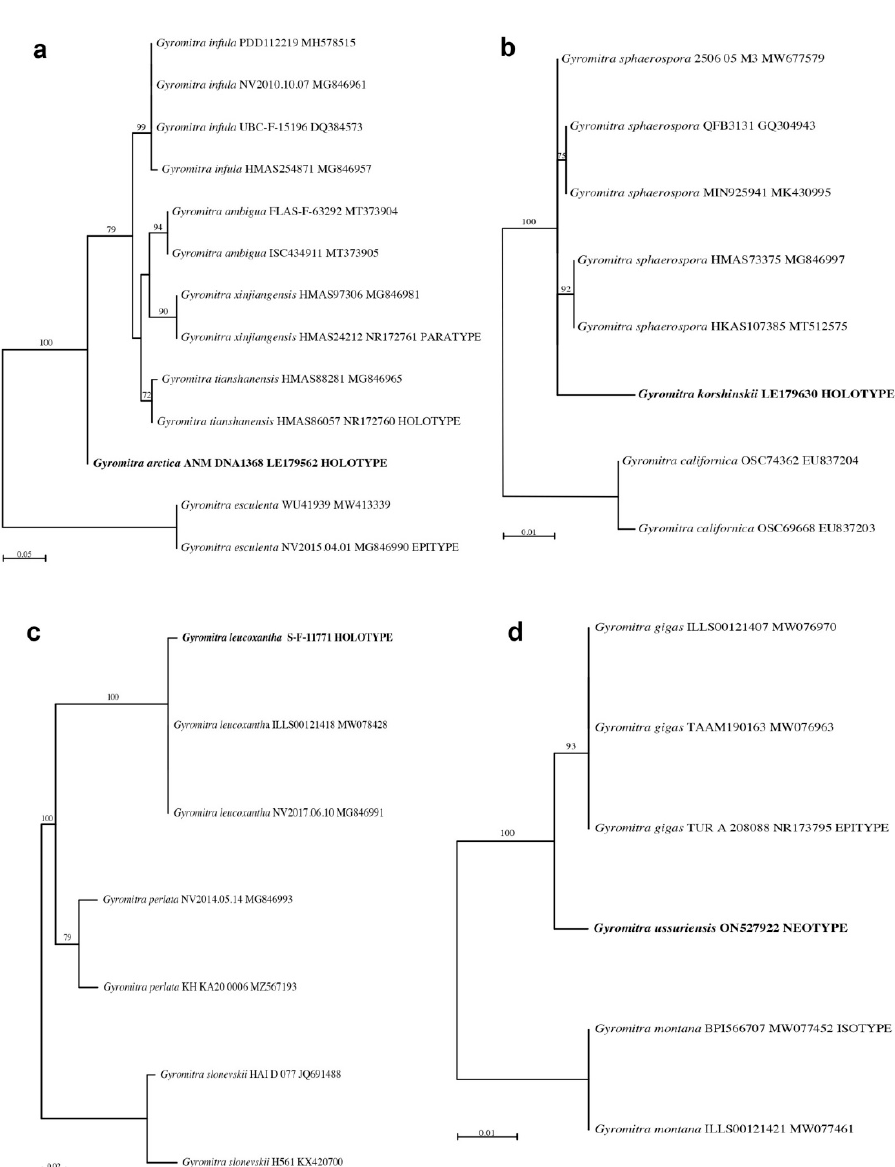
Figure 4. Phylogenetic trees showing the taxonomic placement of the target species based on maximum likelihood analyses of Illumina-generated ITS2 (or ITS in ( b )) sequences. The taxonomic name followed by the fungarium number and GenBank accession number are given for each taxon. The target species are shown in bold font. Bootstrap values > 50% are shown above